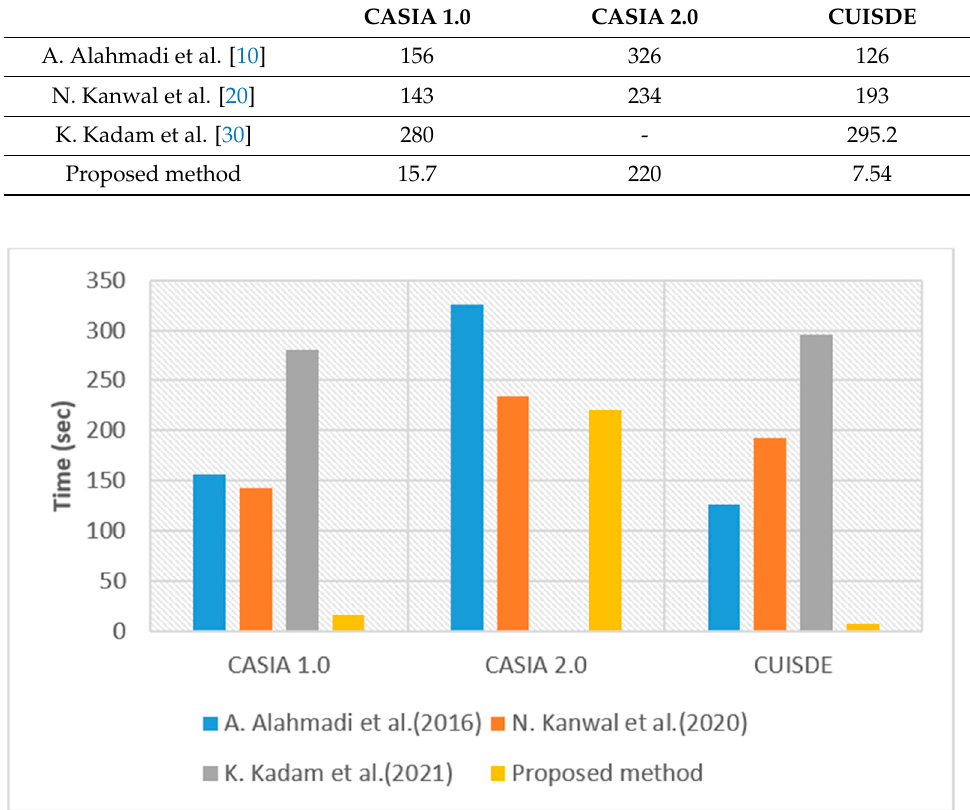
Speed Recognition (Time) CASIA 1.0